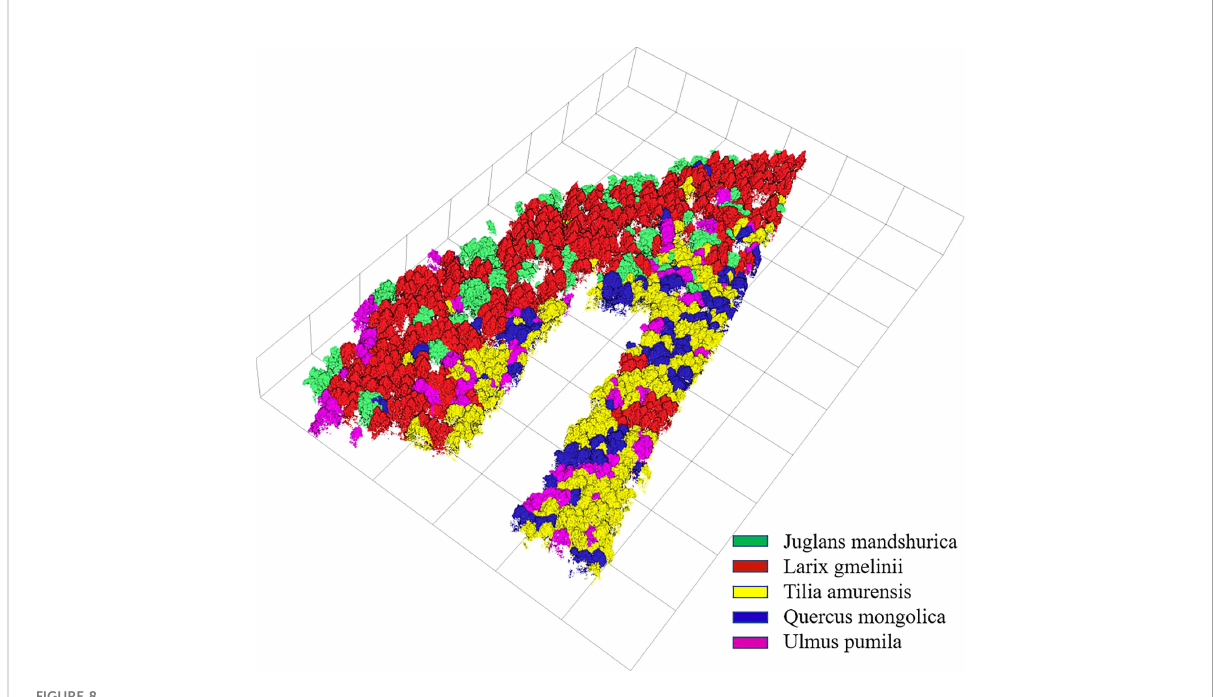
FIGURE 8 Thematic map of tree